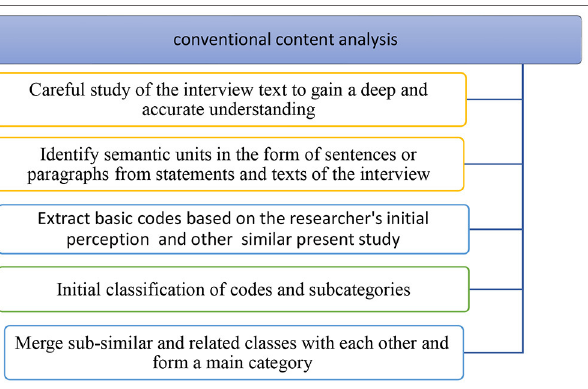
TABLE 2 | Conventional content analysis. TABLE 3 | Categories and